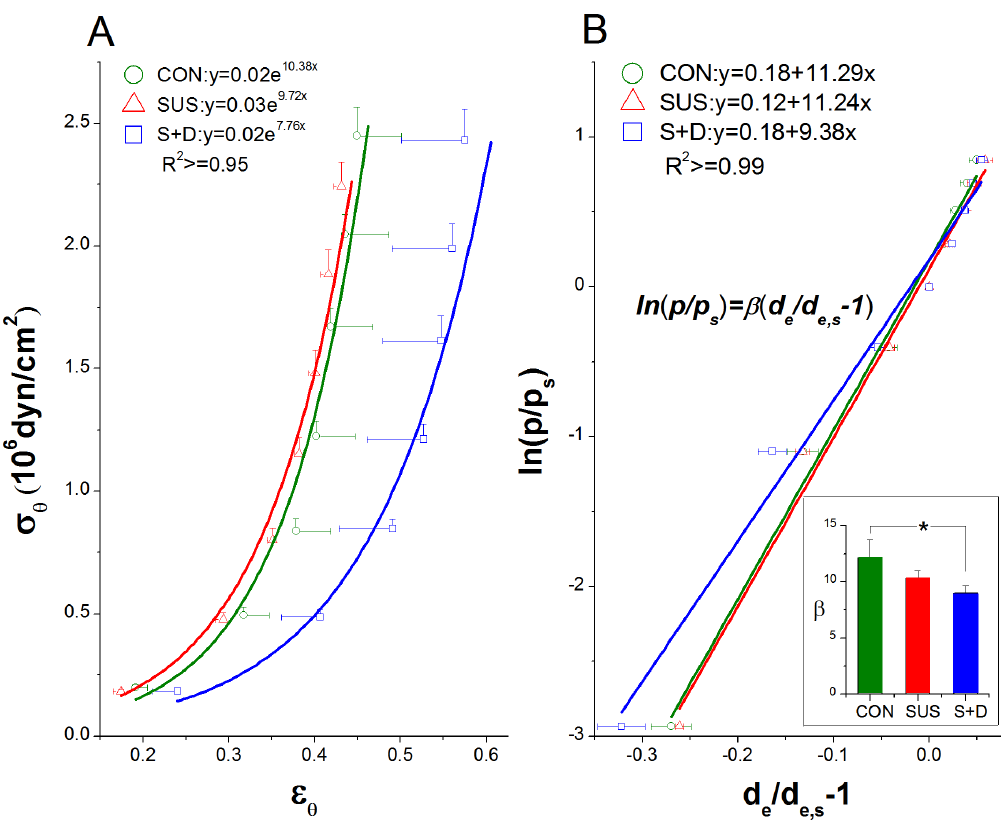
Fig. 3. Comparison on passive mechanical behavior of middle cerebral arteries among CON, SUS, and S + D groups. (A) Circumferential stress ( s h )-strain ( e h ) relationship for passive vessels calculated from the data of the second run. Both s h and e h are calculated at the external radius. Fitted curves are also shown with corresponding exponential equations and R 2 values. (B) A representative linear regression between the logarithm of pressure ratio versus the mean value of the distension ratios with the averaged values of the calculated stiffness parameter ( b ) being shown in the bottom right inset. The calculation was based on the data from the second run. The reference pressure (p s ) was 75 mmHg. Values are means 6 SE. n =8 , 10 per group.* P , 0.05 (1-way ANOVA).